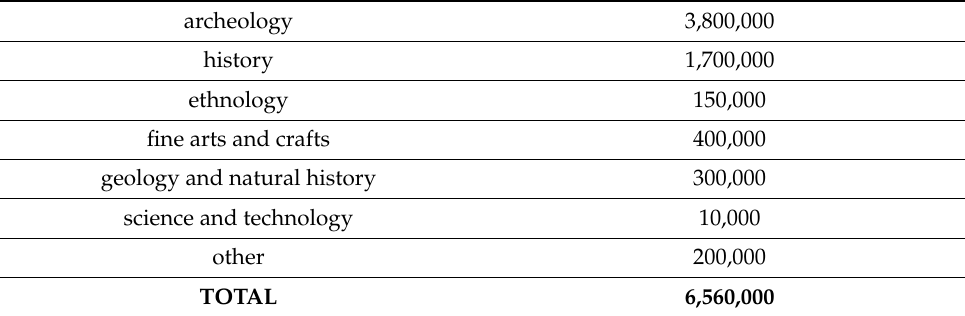
Table 1. Numbers of cultural heritage artifacts in Slovene